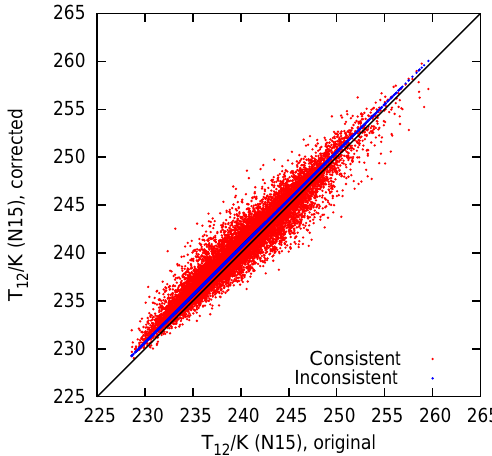
Figure A1. Consistent (red points) and inconsistent (blue points) use of the bivariate regression coefficients for correction of chan- nel 12 brightness temperatures from NOAA 15. The black line is the diagonal y = x , included to guide the